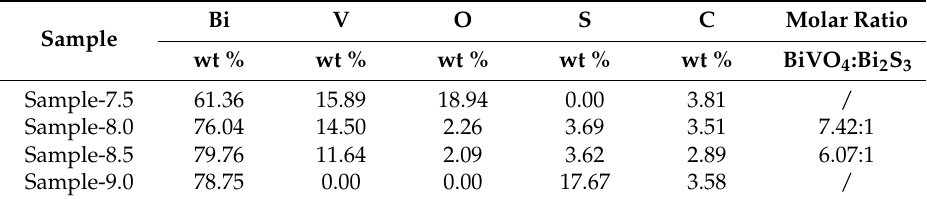
Table 1. Sample composition based on EDX.